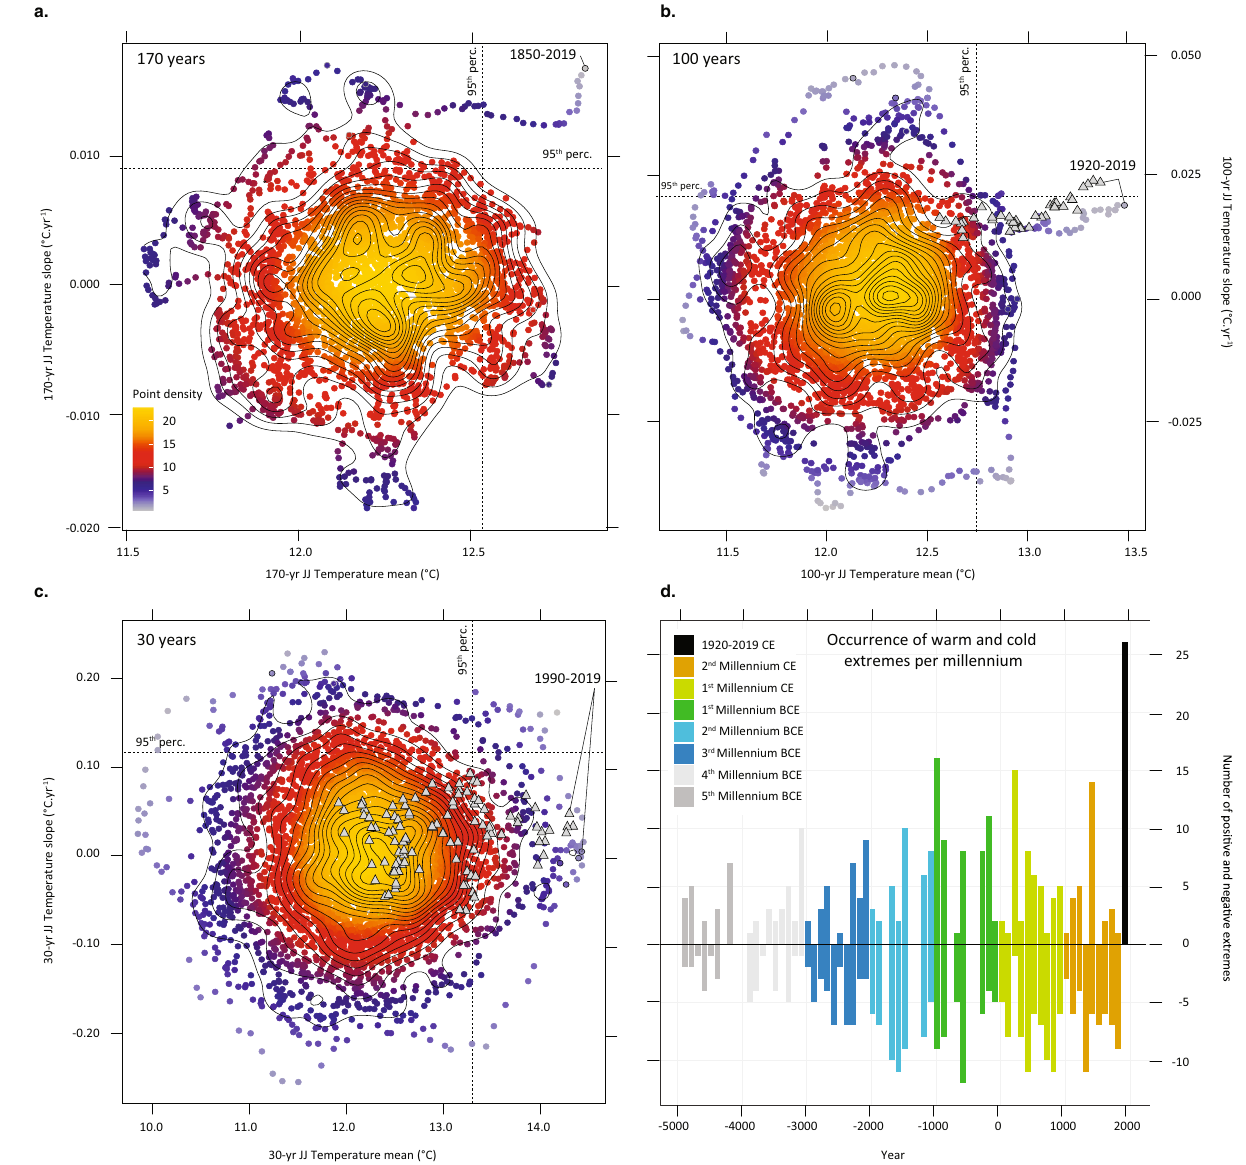
Fig. 4 | Recent June – July(JJ)warming unprecedentedoverpast7638 years.a – c Two-dimensional density plots of temperature trends versus mean temperatures computedfortimewindowsof170,100,and30years.Graytrianglesindicatemean temperature anomalies and slopes computed for the Salekhard meteorological dataset. Time windows including years with EPS<0.85 were excluded from the analyses. Labeled dots indicate the period ending in 2019 CE. Results show that a industrial-era warming (1850 – 2019 CE) is unprecedented in terms of slope and